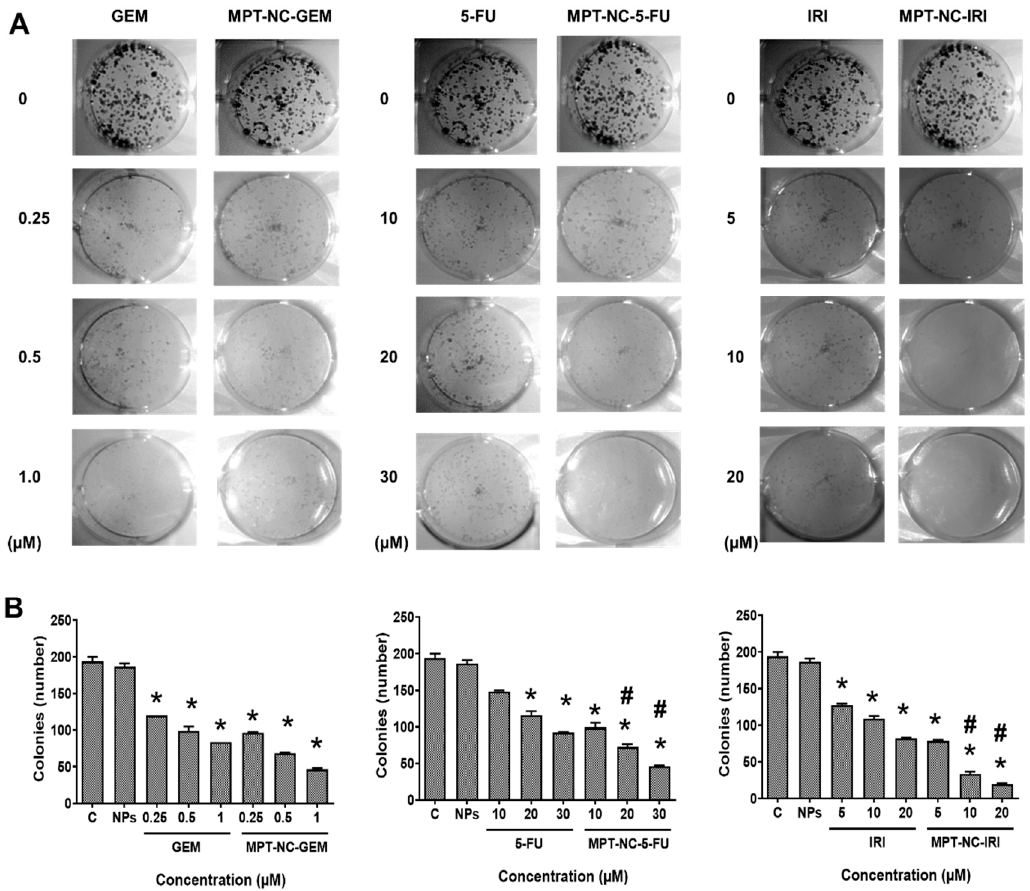
Figure 6. MPT-NCs inhibit the colony formation of PANC-1 cells. ( A ) Representative images of colonies for the predetermined treatment groups (control / blank MPT-NCs and drug containing MPT-NCs). ( B ) Total number of colonies quantified using ChemDoc software. Data represented as the mean ± SEM, n = 3. * p < 0.05 of GEM, 5-FU, and IRI concentration and drug containing MPT-NCs compared to un-treated / control cells, and # p < 0.05 of drug containing MPT-NCs compared to GEM, 5-FU, and IRI treated cells.